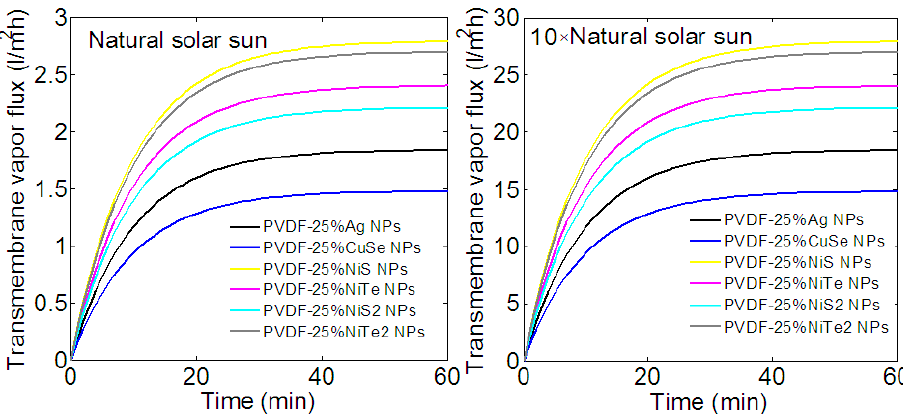
Figure 6. Time-dependent transmembrane vapor flux of different composite membranes for two solar intensities. After 1 h of illumination the highest transmembrane vapor flux is about 26–27 L/m 2 h for amplified intensity and 2.7 L/m 2 h under the natural sun. A membrane loaded with NiTe and NiS 2 NPs can produce about 22 and 24 L/m 2 h of vapor flux. The increasing transmembrane vapor flux with temperature can be explained if we